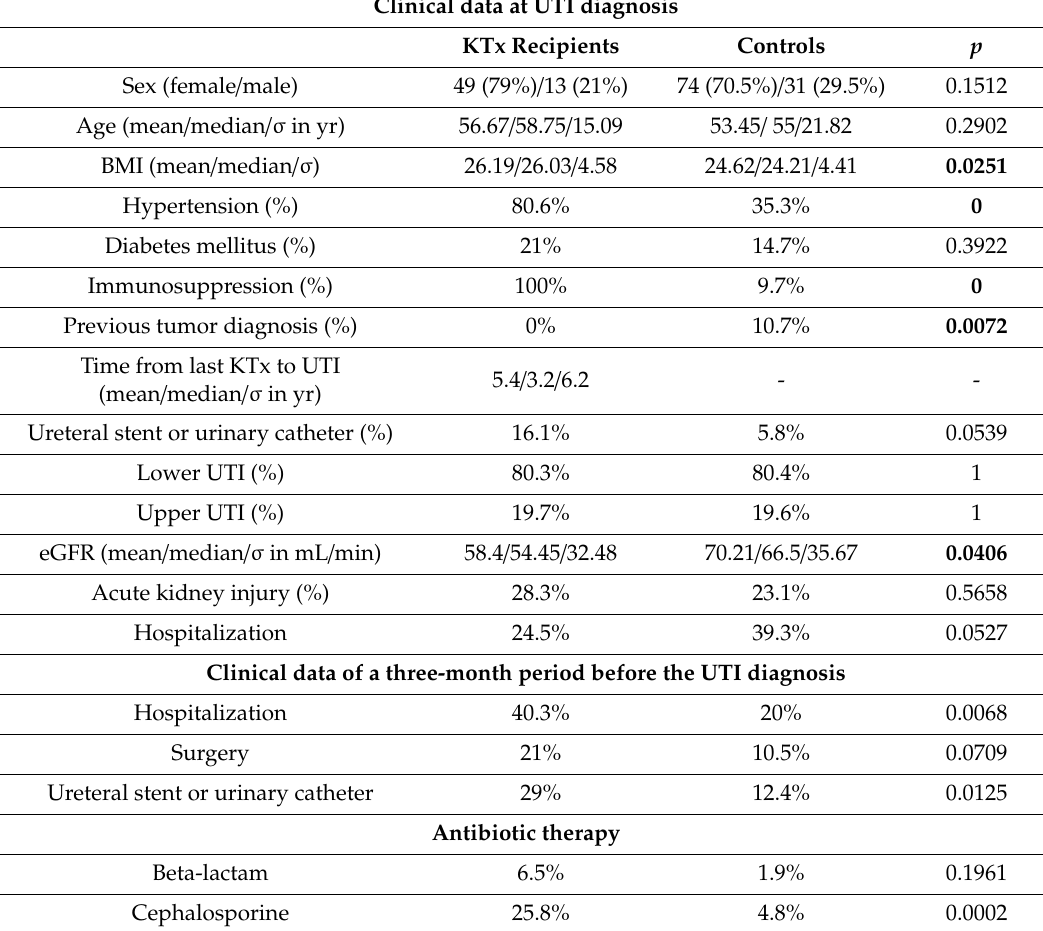
Table 1. Clinical data. Clinical data at UTI